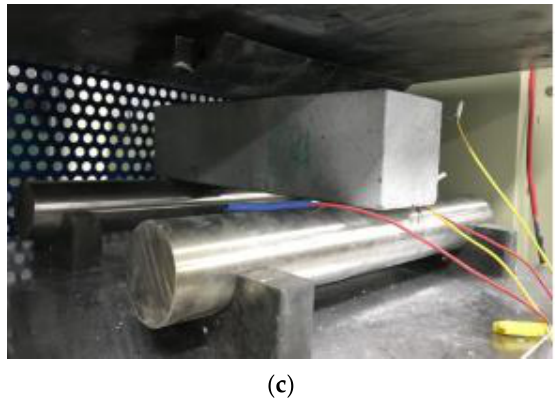
Figure 5. ( a ) Compressive, ( b ) splitting tensile capacity, and ( c ) flexural tests.